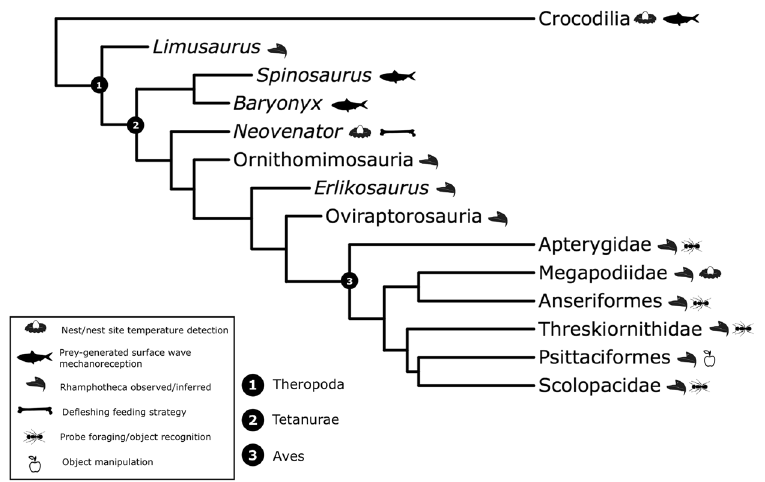
Figure 5. A schematic phylogeny representing the archosaurs mentioned in the text, and their inferred palaeoecology as a result of the presence of mandibular foramina an/or internal neurovascular structures.